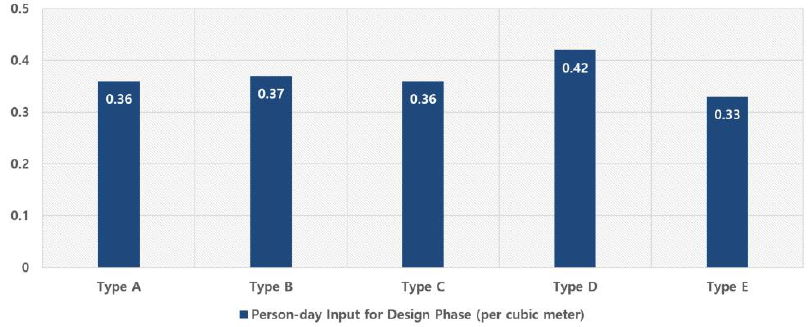
Figure 6. Design cost analysis (person-day input for design phase).